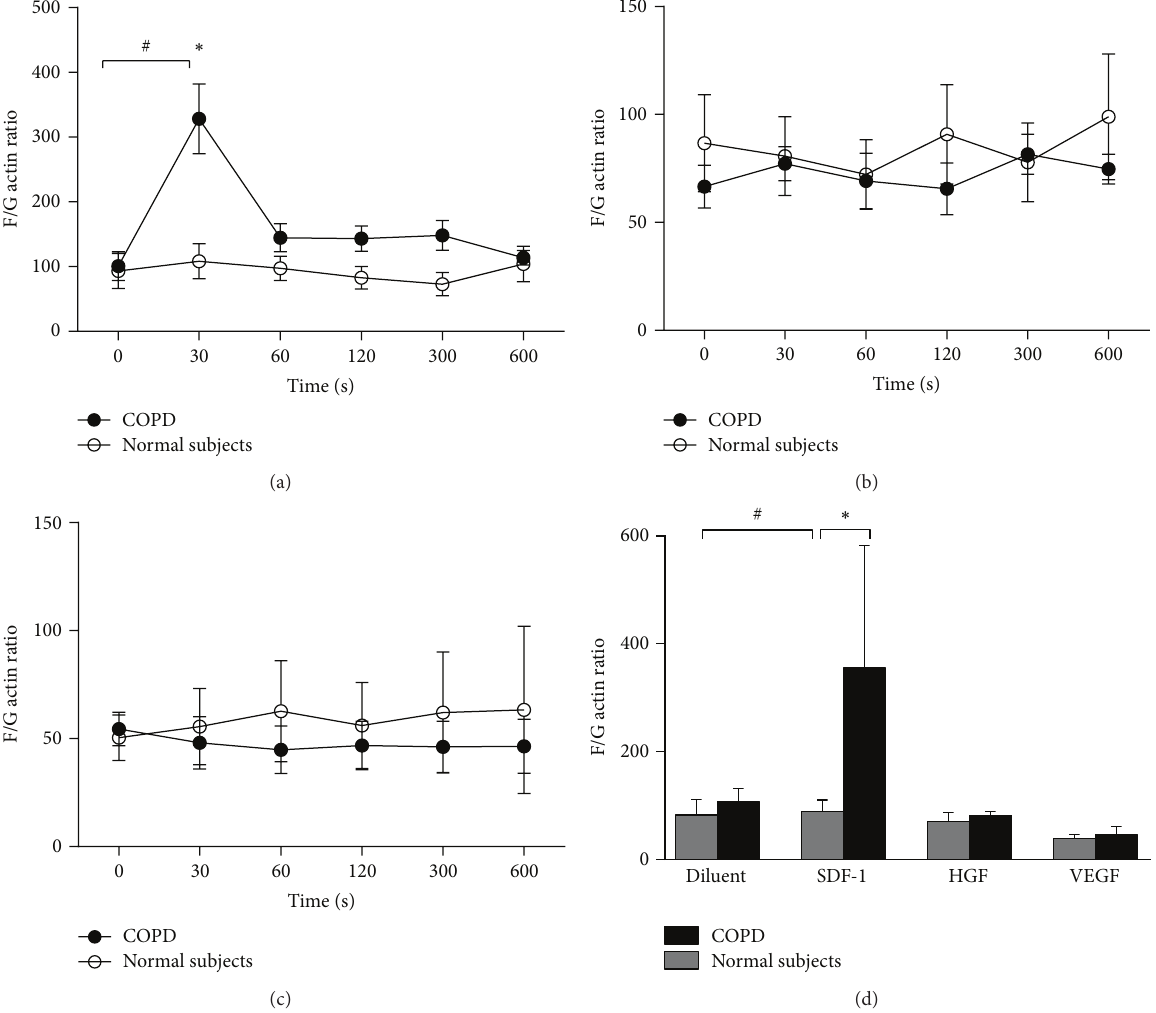
Figure3:MigrationalresponsivenesstobloodHPCassessedbyintracellularF/Gactinratiofollowingincubationwithpredeterminedoptimal dose of (a) SDF-1 𝛼 (10ng/mL), (b) HGF (50ng/mL), or (c) VEGF (50ng/mL) at varying time-points. Summary F/G actin ratio data are presented in (d) following 30 seconds of stimulation. Data are presented as mean ± SEM ( 𝑛 = 8 ); ∗ 𝑝 < 0.05 between group comparisons and # 𝑝 < 0.05 within group comparisons to diluent